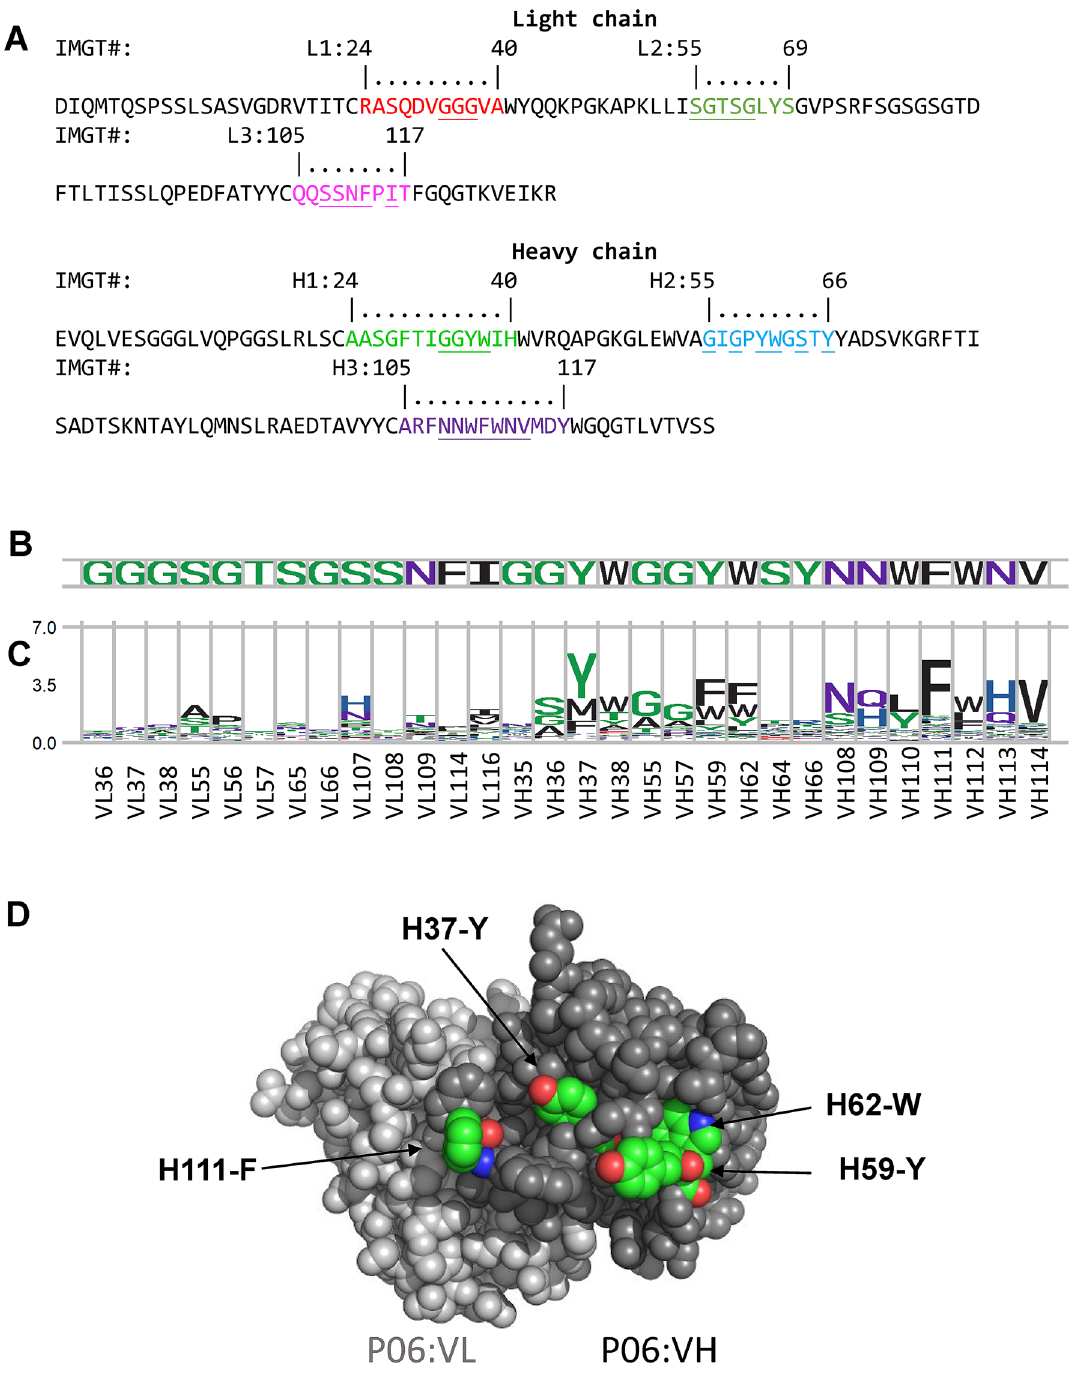
Figure 5. Amino acid type preferences for antibody P06 binding to HA. Antibody P06 binding to influenza hemagglutinin (HA) had been attained from the phage-display synthetic antibody libraries developed in our lab 55,64 . ( A ) The sequences of the VL and VH domains of P06 are shown with the CDRs highlighted in colors with IMGT numbering. ( B ) The subset of CDR positions (x-axis) in P06 (underlined in the sequences in ( A )) were enumerated in degenerate codon NNK with phage-displayed synthetic antibody libraries, and the CDR variants of P06 binding to the native epitope of HA were selected and screened from the phage- displayed synthetic antibody libraries. The experimental procedure was followed without modification as in our published works 48,62 . The CDR sequences of these CDR variants of P06 are listed in Supplementary Table S5. ( C ) The amino acid type preferences for the HA-binding CDR variants of P06 are shown as sequence LOGO (Supplemental Methods) for each of the CDR positions (x-axis) calculated with the CDR sequences of the CDR variants of P06 in Supplementary Table S5. ( D ) The antibody P06 VL (colored in grey) and VH (colored in black) variable domain structures were computationally modelled with RosettaAntibody modeling software 63 with default parameters. The four CDR positions highly conserved in aromatic amino acid types are highlighted in green for the aromatic carbon